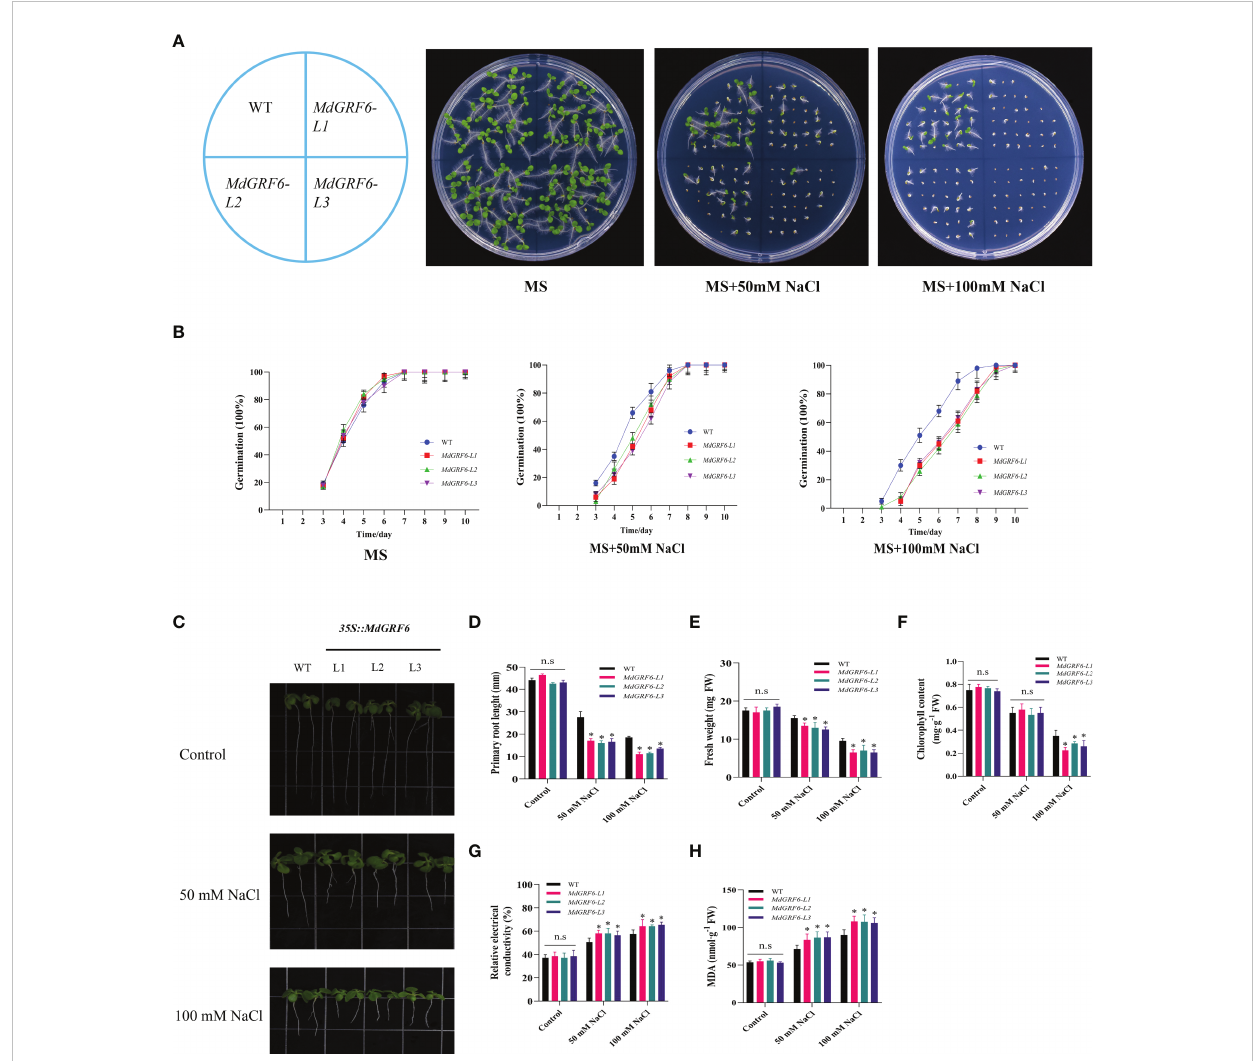
FIGURE 5 Salt response of 35S::MdGRF6 transgenic tobacco plants during germination. (A) Effects of salt treatment on the germination of WT and 35S:: MdGRF6 transgenic tobacco lines. Germination was assessed at the indicated time. (B) The WT and 35S::MdGRF6 transgenic tobacco lines were grown on MS medium supplemented with 0, 50, or 100 mM NaCl. The seeds germinated after 10 days. Representative seedlings are presented in the images. (C) The seedlings were grown vertically for 4 days on MS medium and then moved to the medium containing different doses of 50 or 100 mM NaCl for an additional 10 days in a vertical position. (D) Root elongation of WT and 35S::MdGRF6 transgenic tobacco seedlings in response to salt stress. (E – H) Fresh weight (E) , chlorophyll content (F) , relative electrical conductivity (G) , and MDA content (H) in WT and 35S::MdGRF6 transgenic tobacco seedlings under control or salt stress conditions. Error bars indicate the means ± SD (n = 3). The asterisks indicate signi fi cant differences (LSD test, * P < 0.05; ns, no signi fi cant